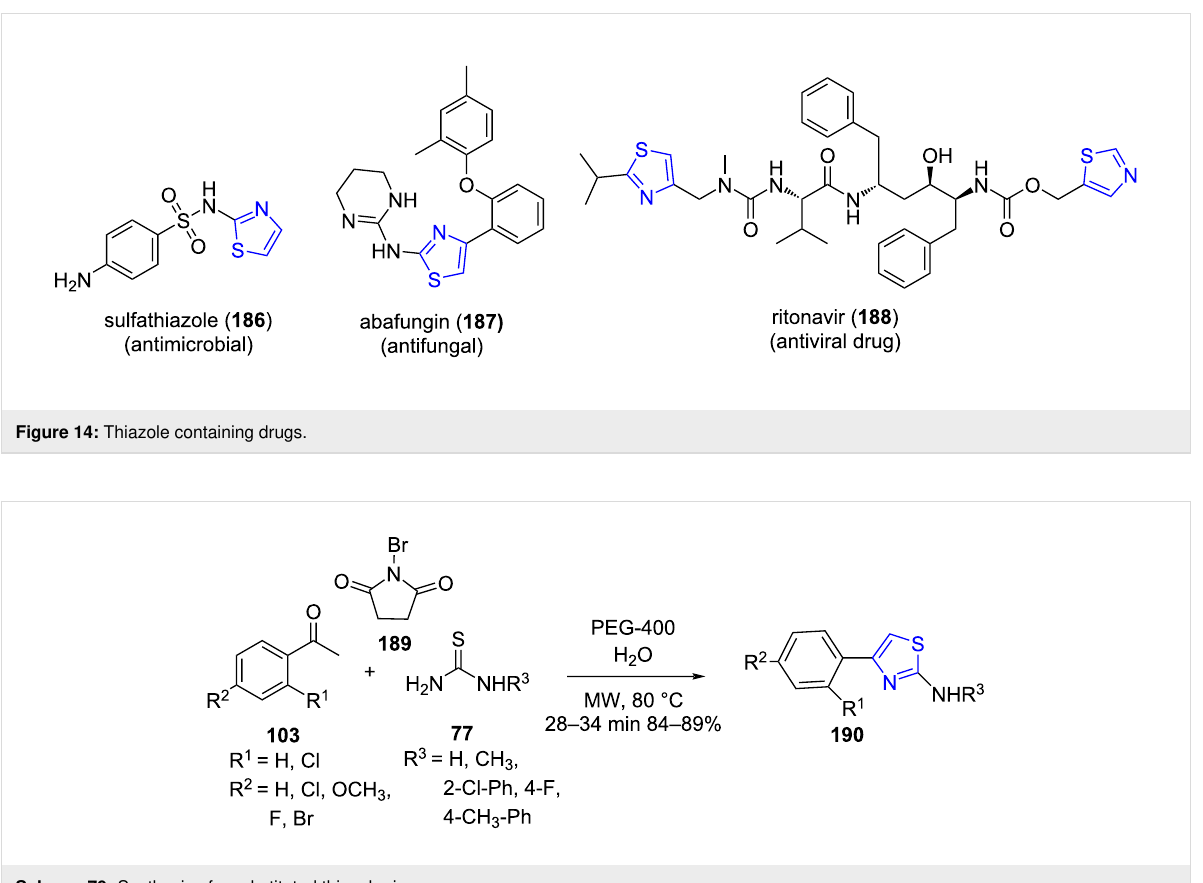
Scheme 79: Synthesis of a substituted thiazole ring.